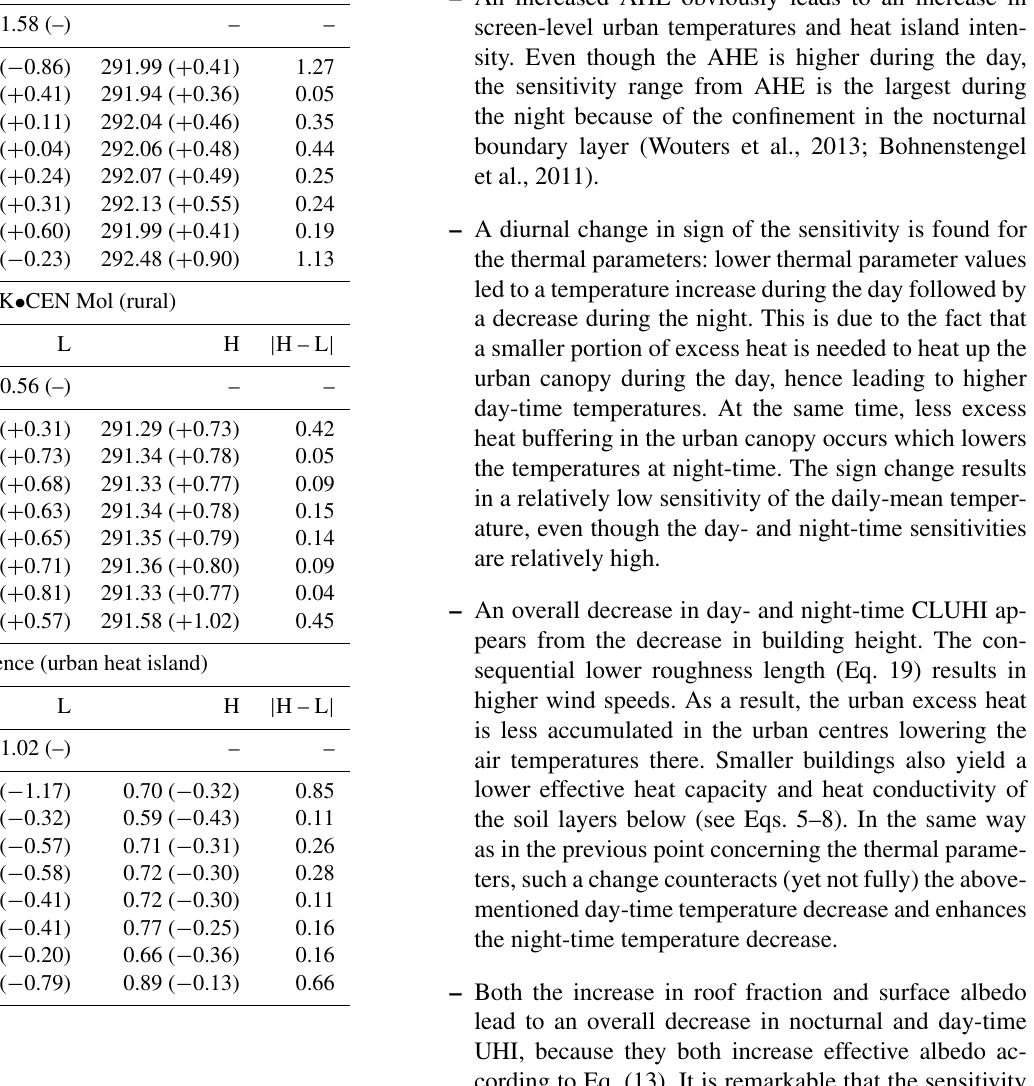
layer temperatures, except for the change in the screen-level and boundary-layer temperatures when altering